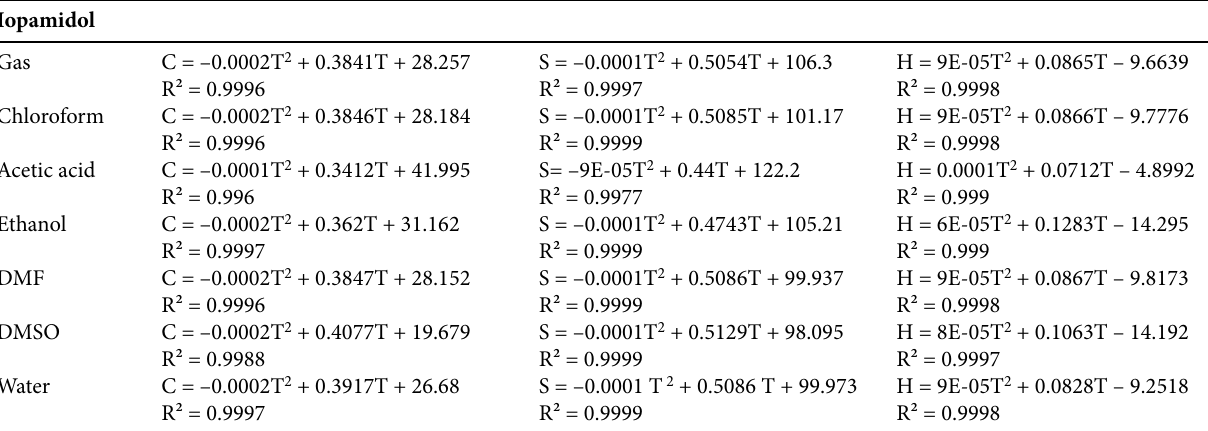
Table 5 . Correlation of heat capacity, entropy and enthalpy with temperature for Iopamidol molecule